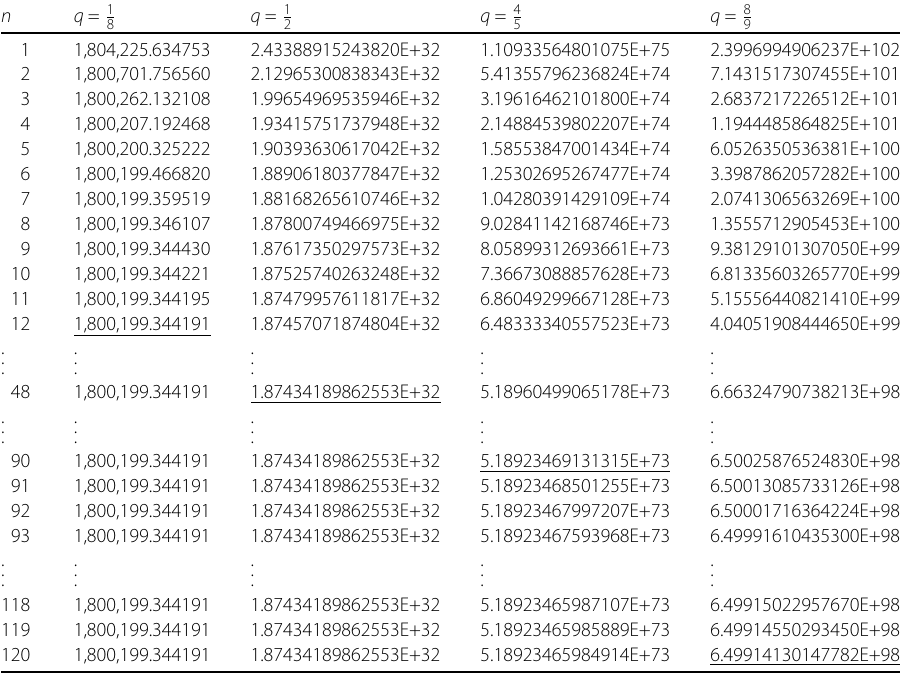
, 1 , 4 , 8 for x = 110 of Algorithm 2 8 2 5 9